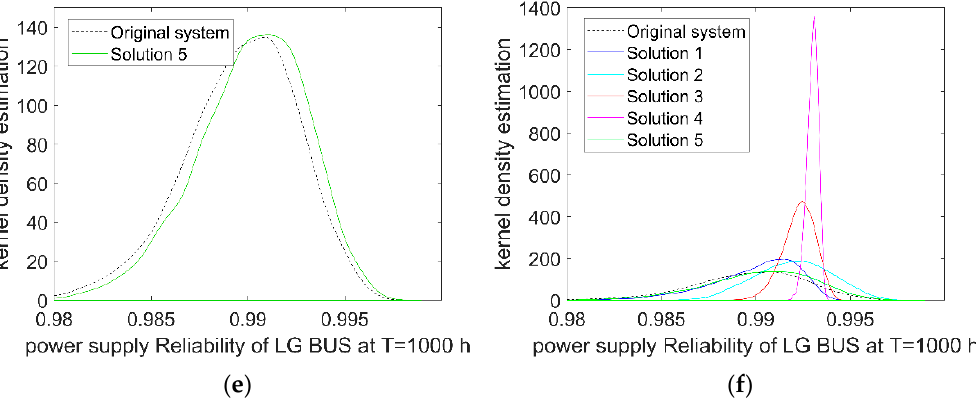
Figure 6. Kernel density function of system reliability after different improvement solutions are applied. ( a ) Kernel density function of system reliability after solution 1 is applied; ( b ) Kernel density function of system reliability after solution 2 is applied; ( c ) Kernel density function of system reliability after solution 3 is applied; ( d ) Kernel density function of system reliability after solution 4 is applied; ( e ) Kernel density function of system reliability after solution 5 is applied. ( f ) The comparison of the kernel density function of system reliability of five solutions.